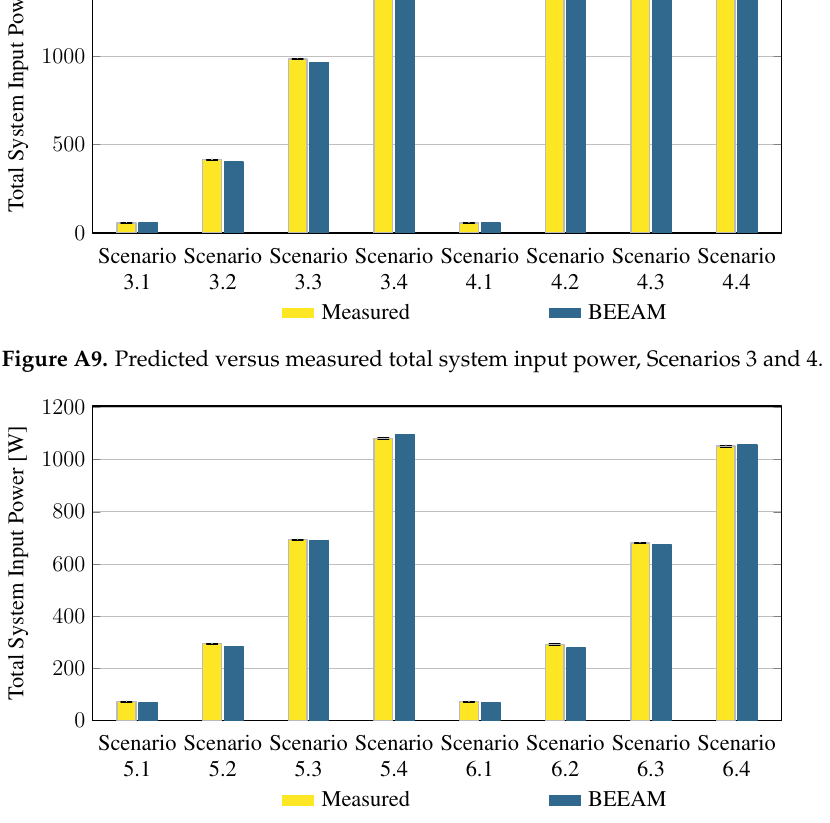
Figure A10. Predicted versus measured total system input power, Scenarios 5 and 6.